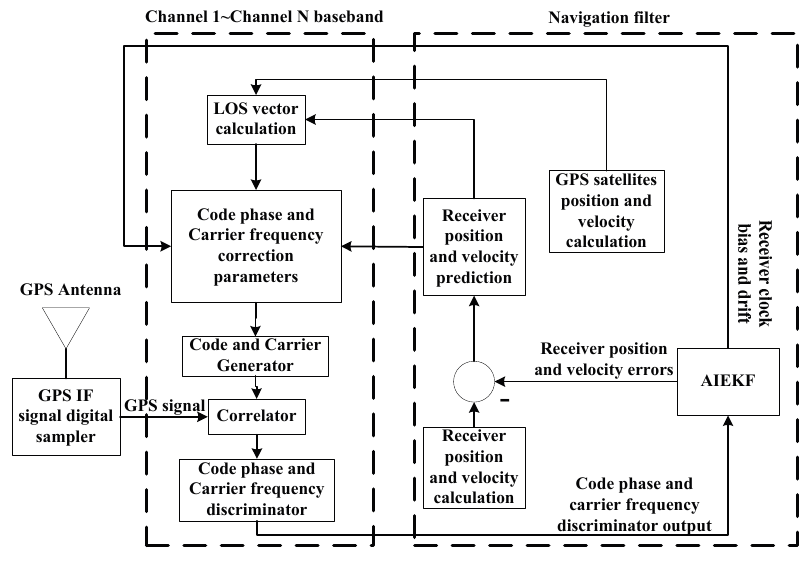
Figure 3. Flowchart of vector-tracking loop based on AIEKF.